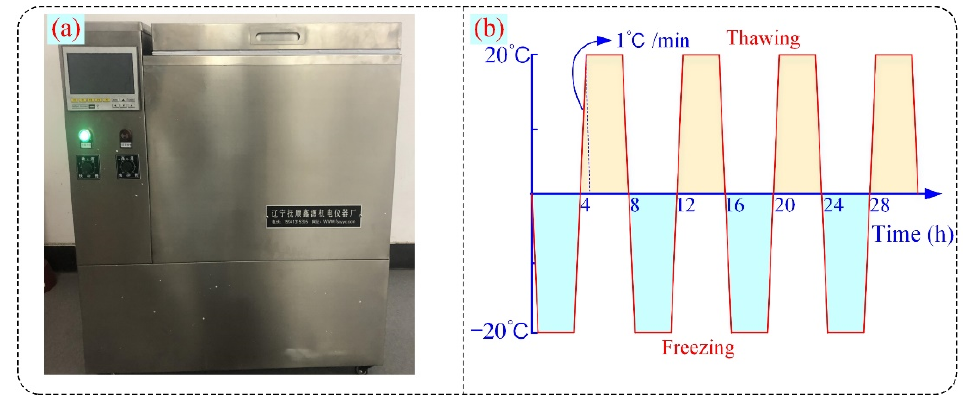
Figure 3. F–T chamber ( a ) and cyclic temperature setting ( b ).